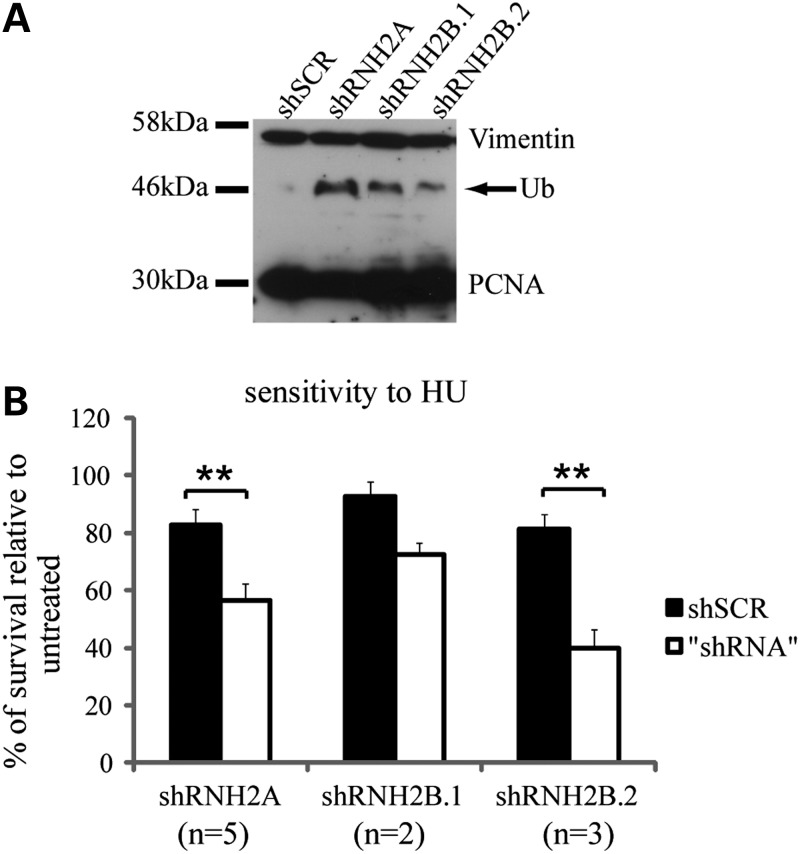
Inactivation of RNase H2 induces replication stress. Immunoblot on total protein extract from control and RNase H2A/B silenced HeLa cells against PCNA. Vimentin was used as loading control (A). Sensitivity to HU was evaluated by colony forming assay. Control and silenced HeLa cells were incubated for 14 days with or without HU 0.1 mm. The histograms report the percentage of surviving colonies respect to the untreated sample. Experiments were performed in duplicate or triplicate. Error bars represent mean ± s.e.m. (B). **P < 0.003 (t-test).